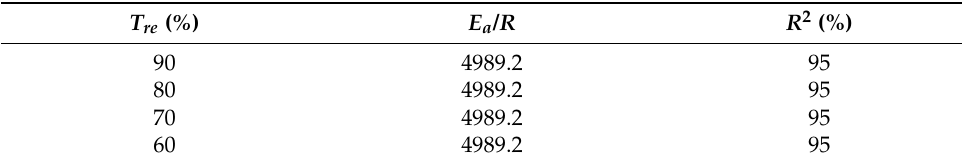
Table 16. Values of E a / R (G1) based on the fourth prediction